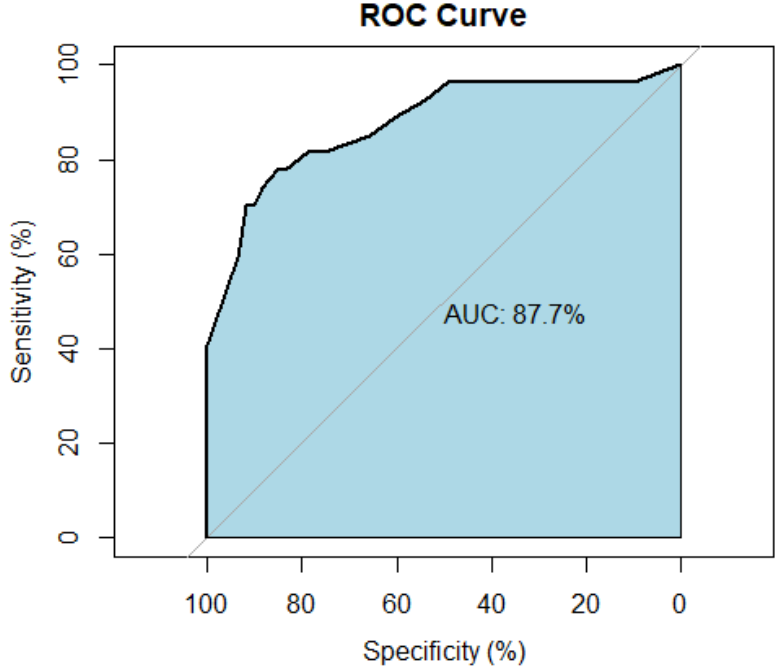
Figure 3. The ROC curve with an AUC of 0.877 to demonstrate the discriminatory ability of the nomogram for predication of pCR in TNBC patients receiving NAC. ROC: receiver operating characteristic (ROC) curve. AUC: area under the curve, representing the discrimination of the nomogram.